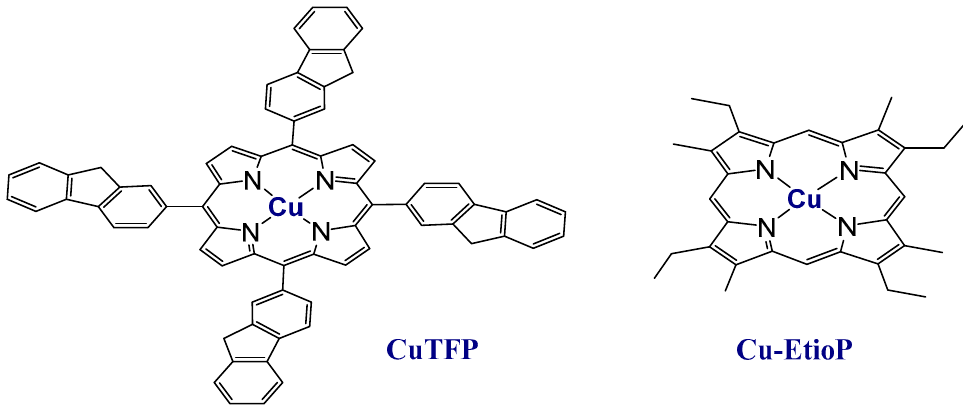
Figure 1. Structural formulas of copper(II) tetrafluorenyl-porphyrinate CuTFP and copper(II) etioporphyrinate Cu-EtioP.